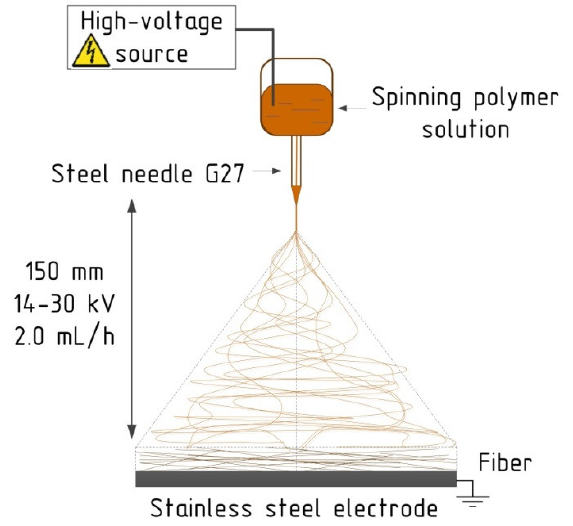
Figure 2. The schematic representation of electrospinning process and operating parameters.